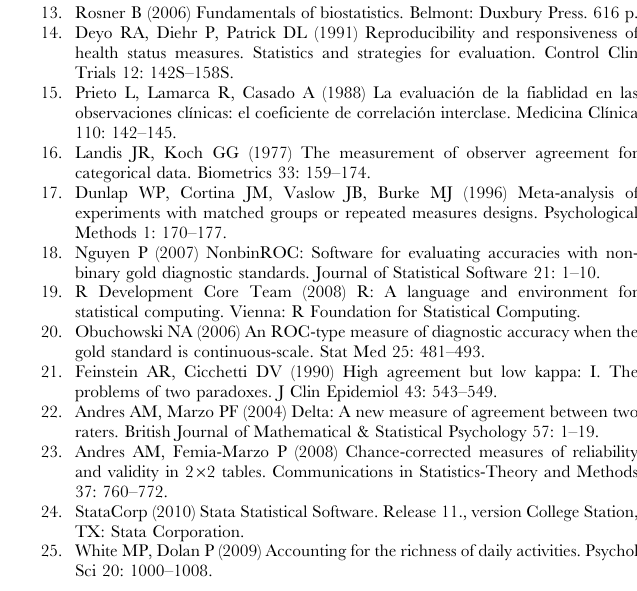
Table S1 Intraclass correlation coefficient (95% CI) between the test and retest evaluations in the affect measures by education, income, and setting (n =1538). Table S2 Final equation for the linear regression analysis: impact of education, quintile of income, and setting over net affect, controlling for sex and age.